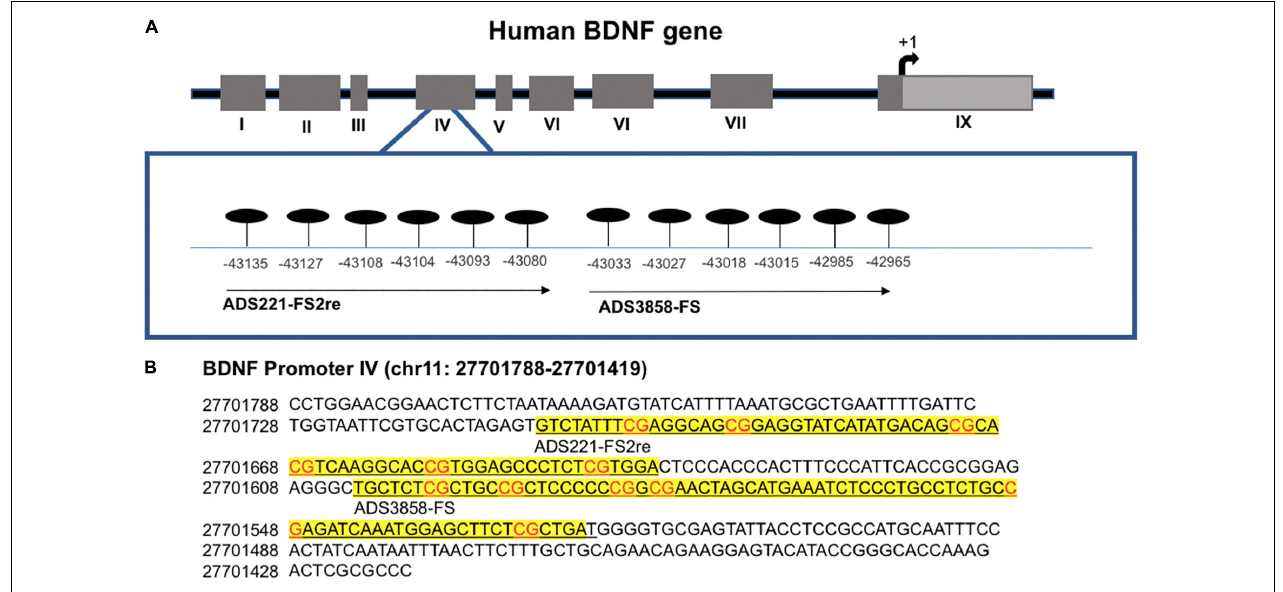
FIGURE 3 | Methylation sites in the BDNF promoter IV region. (A) Schematic representation of human BDNF gene indicating alternative promoters. CpG sites analyzed are detailed in enlarged box. Position is in relation to transcription start site. (B) Detailed sequence of BDNF promoter IV. Underlined text in yellow boxes indicate regions analyzed with each probe by pyrosequencing. Genomic position is based on chromone build GRCh37.p13 primary assembly.